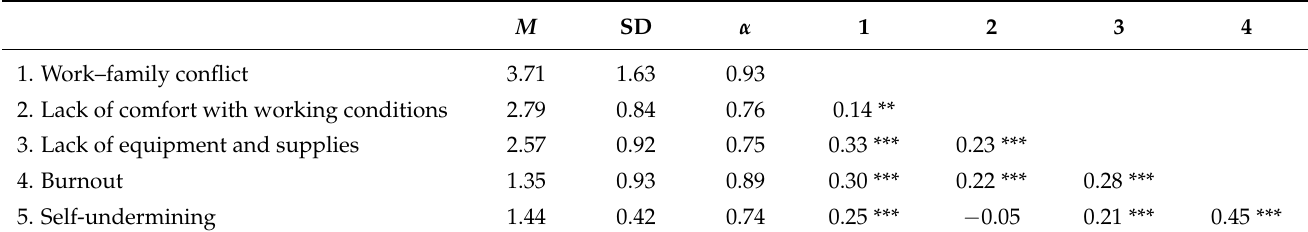
Table 1. Means, standard deviations, reliabilities, and correlations between study variables ( N = 523). M SD α 1 2 3